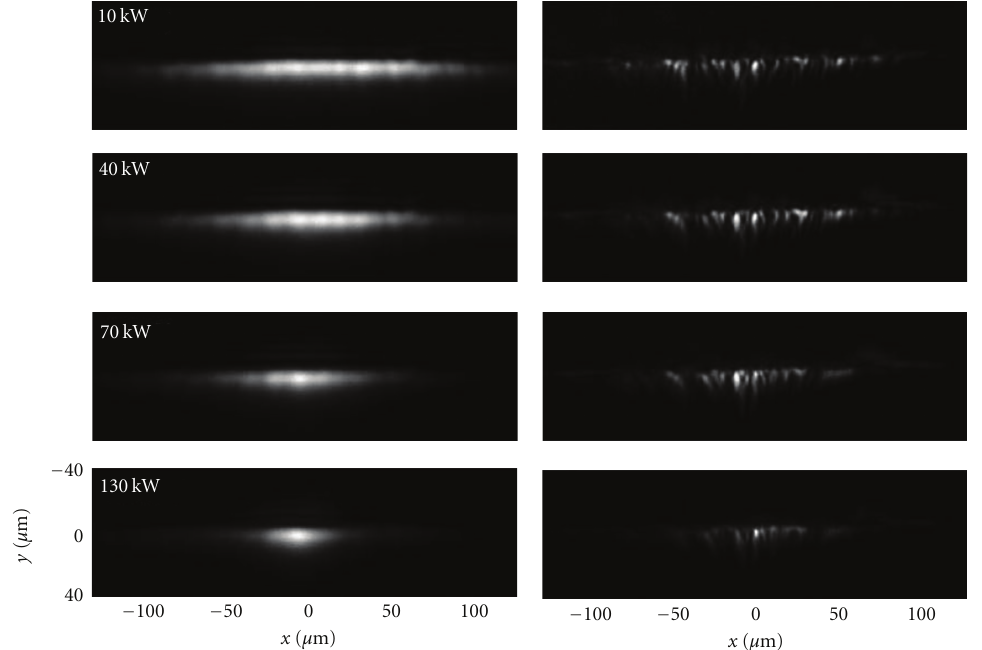
Figure 10: Output spots at FF (left) and SH (right) by a CCD camera for various input peak powers at 985 nm.